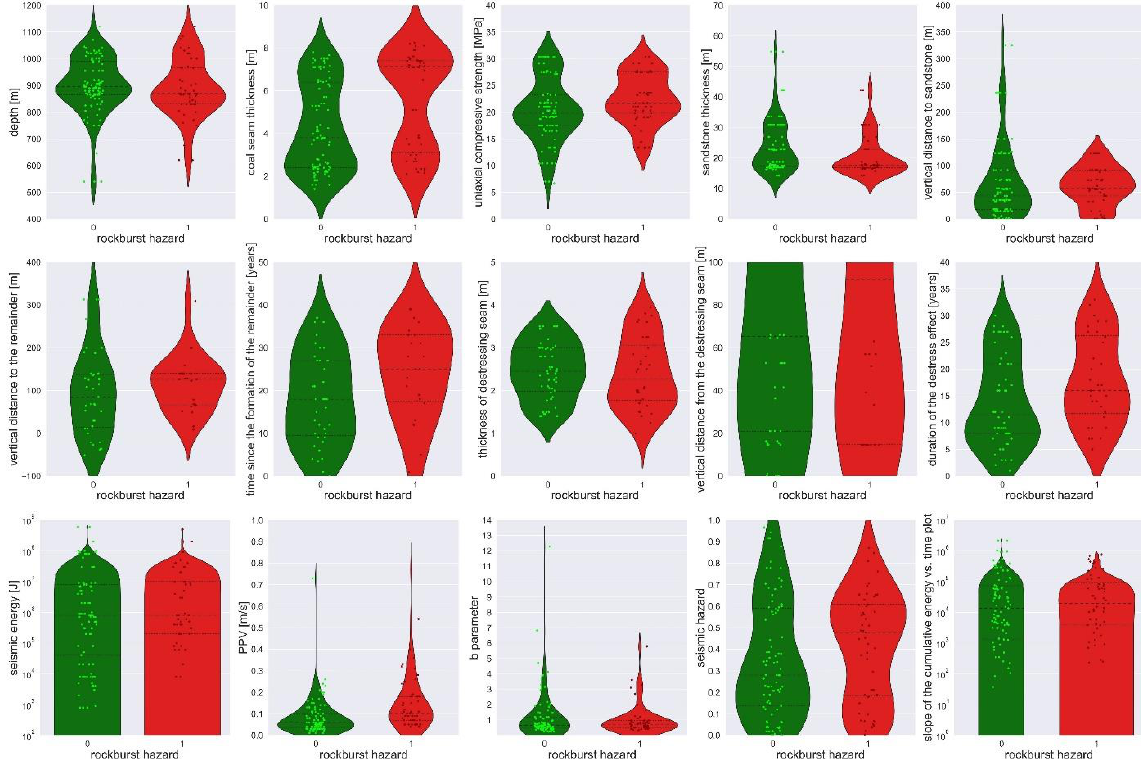
Figure A1. Violin plots of selected indicators influencing the occurrence of rockbursts.